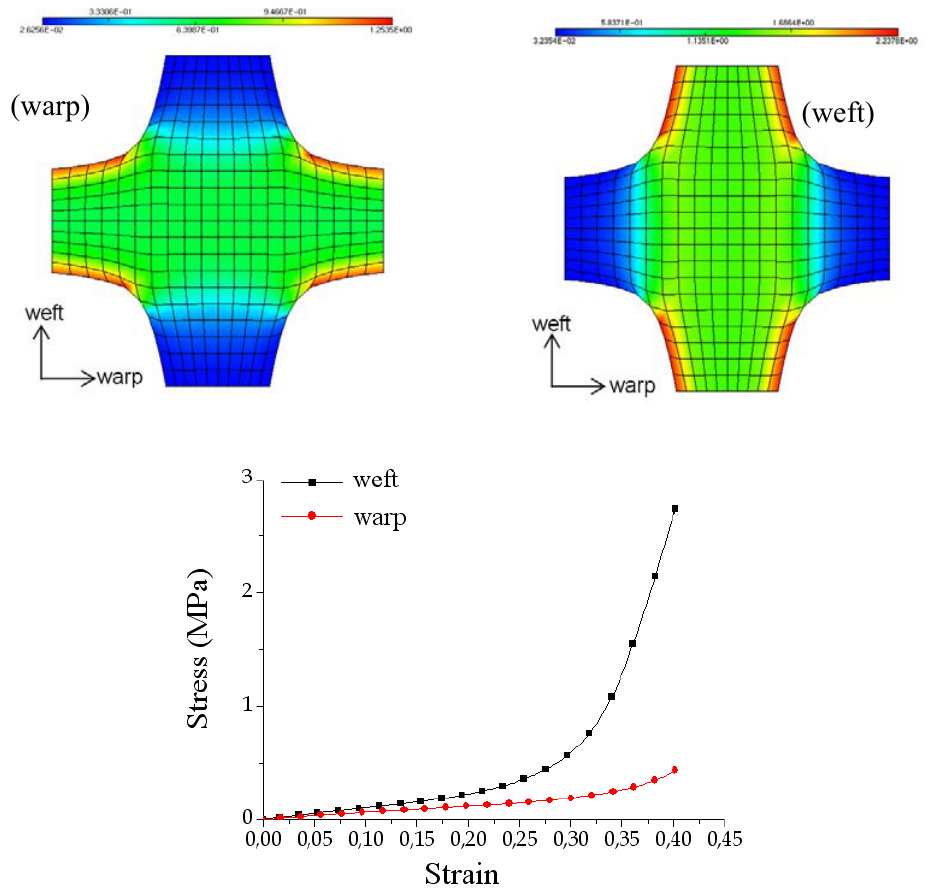
Figure 11. Contour of tensile force (a) warp direction and (b) weft